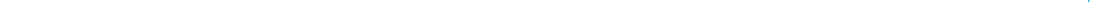
Figure 1: Molecular functioning of replication-deficient viral vectors.Replication-deficient viral vectors are composed of all structural viral pro- teins (here schematically: structural viral proteins 1 and 2), and contain the viral genome. Batch production is performed in so-called “producer cells”, which express one or multiple viral proteins for trans-complementation of the vector’s defective genome. In this example, stably trans- fected producer cells express from their genomic expression cassette the viral “structural protein 2”. The vector genome lacks “structural pro- tein 2”, and encodes only for “structural protein 1” and the “vaccine antigen”. During batch production (left and centre), infectious vector parti- cles infect producer cells, amplify their genome and produce “structural protein 1” as well as the “vaccine antigen”. New infectious particles are formed, containing the genome and structural protein 1 (expressed from the vector genome) as well as structural protein 2 (expressed from the producer cell genome). Upon administration to a vaccinee, these replication-deficient viral particles will infect the vaccinee’s cells, resulting in the expression of structural protein 1 as well as of the vaccine antigen. Owing to the lack of structural protein 2 in the vaccinee’s cells, how- ever, further infectious particles cannot be formed, and the infection does not propagate. Expression of the vaccine antigen in the vaccinee’s cells leads to the desired immune